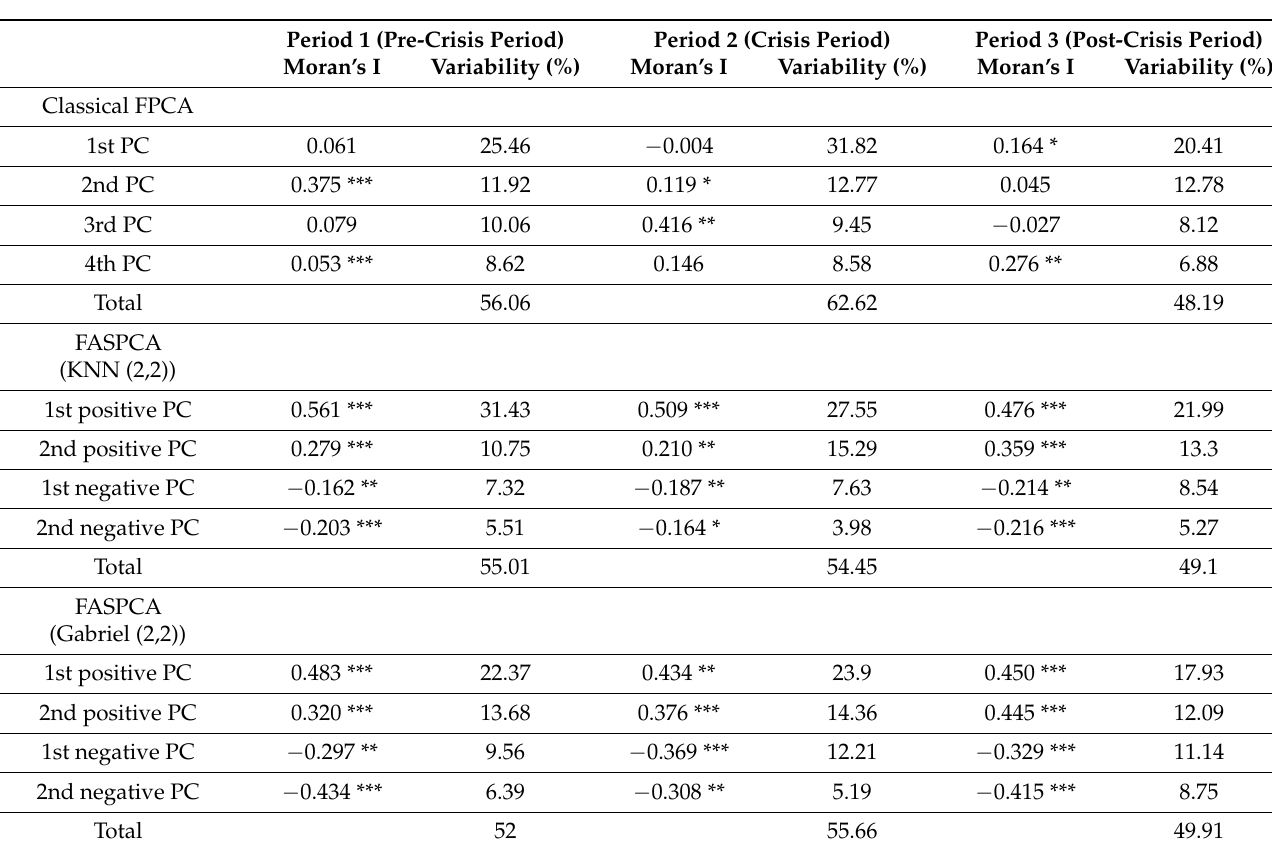
Table 2. Moran’s test on principal components using FPCA and FASPCA, using KNN and Gabriel spatial weight matrices for log return